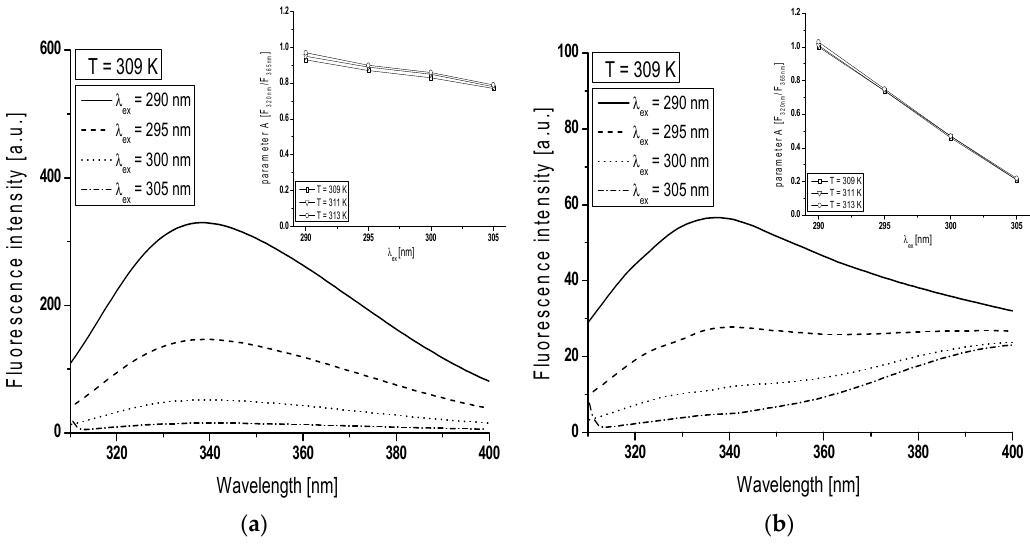
Figure 3. Emission fluorescence spectra of: ( a ) non-glycated (BSA); and ( b ) glycated (gBSA) bovine serum albumin excited at λ ex = 290 nm, λ ex = 295 nm, λ ex = 300 nm and λ ex = 305 nm, T = 309 K. Inserts are plots of parameter A = F 320 nm versus the excitation wavelength at the temperature in the range F 365 nm between 309 K and 313 K for: ( a ) BSA; and ( b ) gBSA.